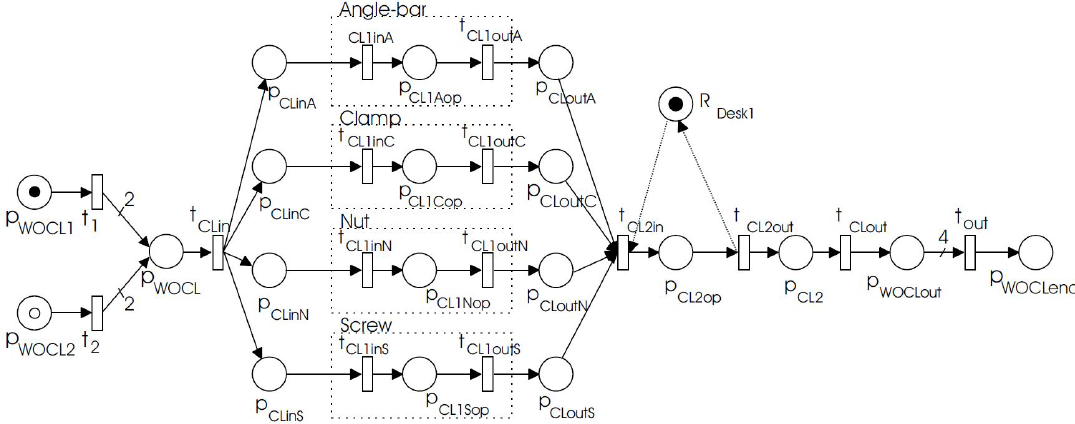
Figure 1. An example of producing an L-shaped corner clamp with four parallel processes (‘Angle-bar with holder L’, ‘Clamp’, ‘Nut’, and ‘Screw’) in Ref.